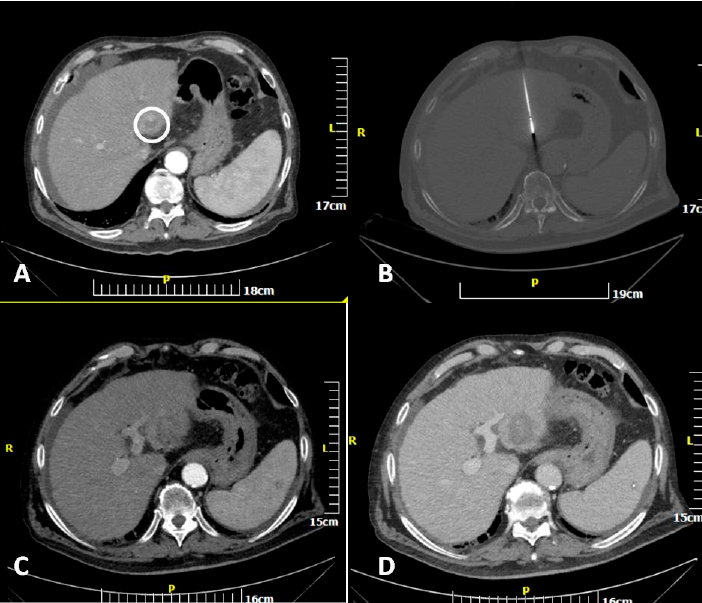
Figure 2. CT scan of an 82-year-old man showing a hepatocellular cancer lesion. Enhanced transverse ( A ) CT image illustrates the lesion (white circle). Transverse CT image ( B ) illustrating the microwave antenna at the lesion level. Transverse CT images in arterial ( C ) and portal venous ( D ) phases illustrating the ablation zone.